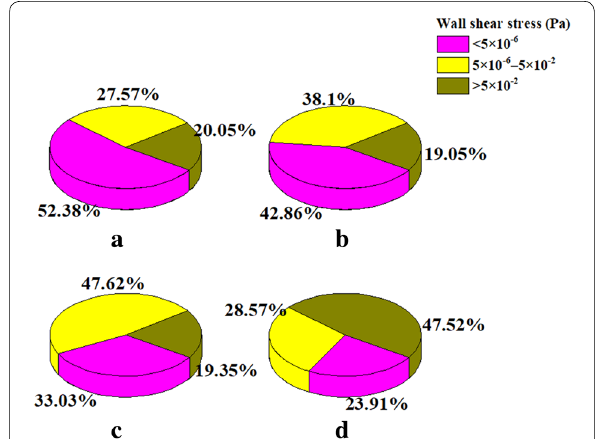
Figure 22 Wall shear stress distribution obtained using CFD simulation (the pore diameter is 434 μm, and the inlet velocity of a, b, c, and d is 0.0025 m/s, 0.005 m/s, 0.0075 m/s, and 0.01 m/s, respectively)